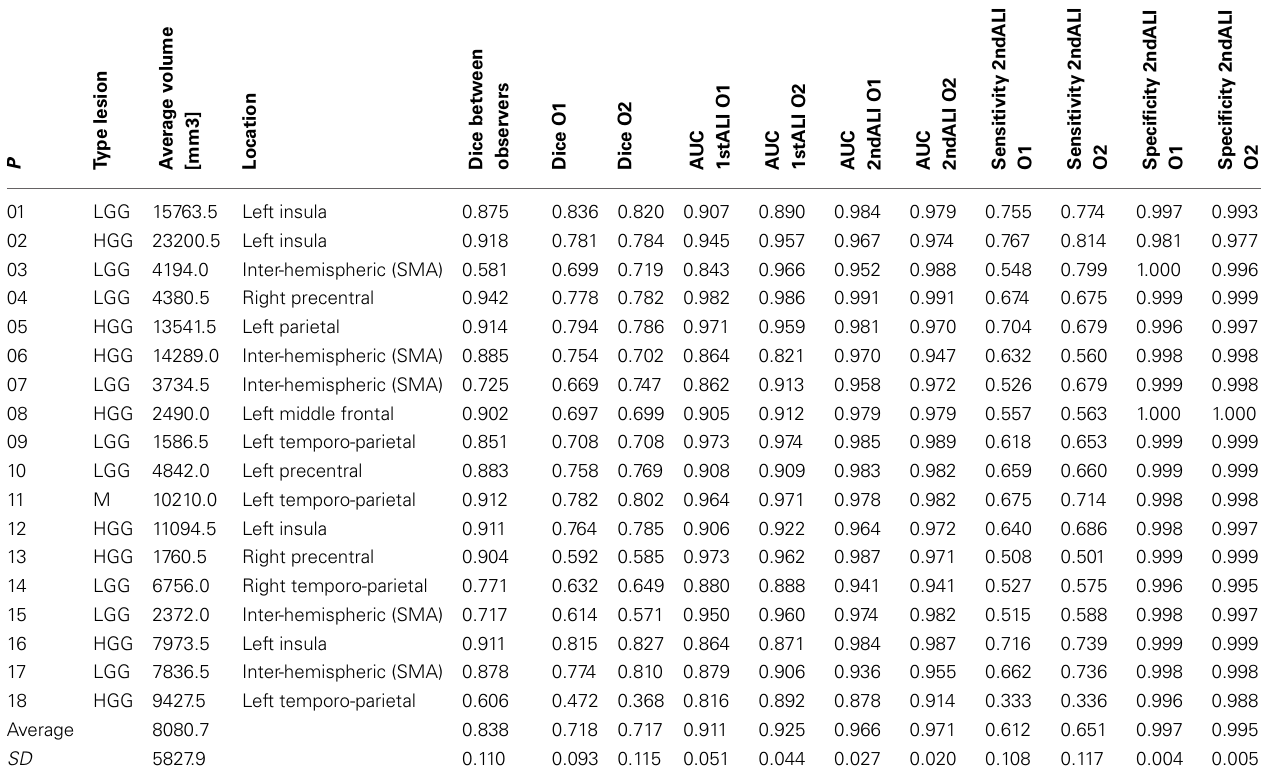
Table 1 | Relevant lesion information (type, size, and tumor location) and similarity measures (Dice and AUC).